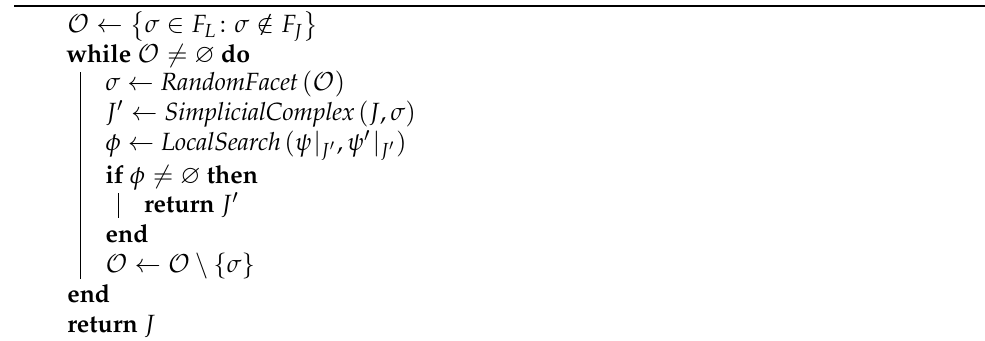
Algorithm 3: AddFacet. A random σ ensures variety of results from multiple